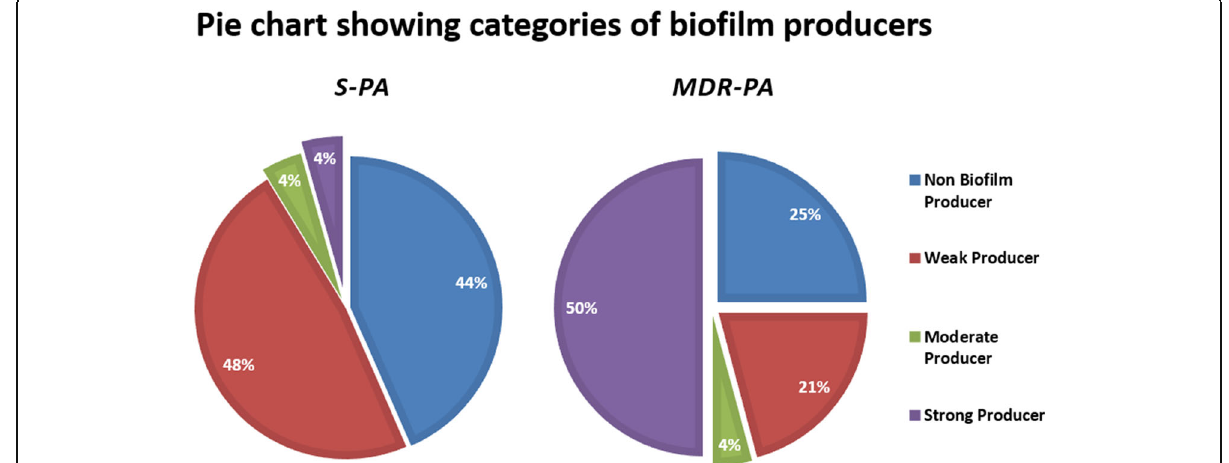
Fig. 4 Graphic representation of a biofilm production by S-PA and MDR-PA group. 50% of the MDR-PA isolates were strong producer whereas in case of S-PA only 4% isolates were strong biofilm